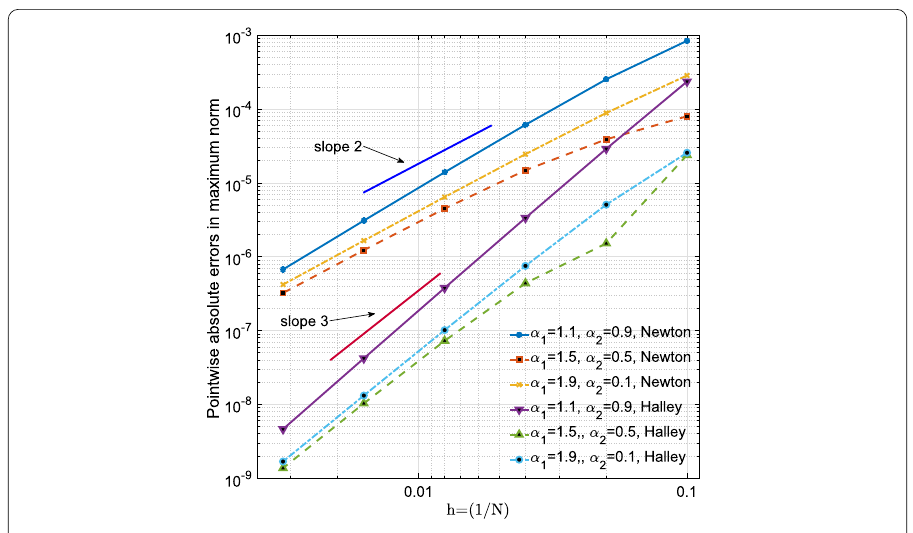
Figure 3 Pointwise absolute errors in maximum norm of Example 4.3 versus the time step h when ( α